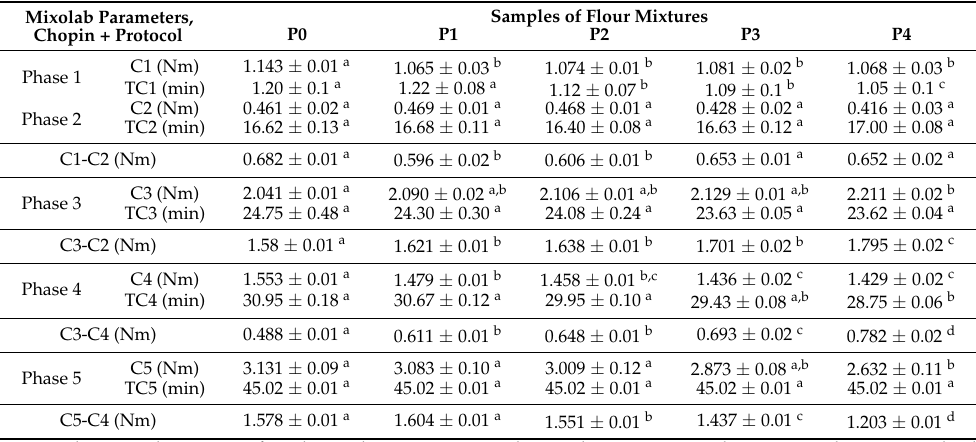
Table 8. Experimental results obtained from rheological and enzymatic analyses performed with the Mixolab apparatus Chopin + protocol for the five flour